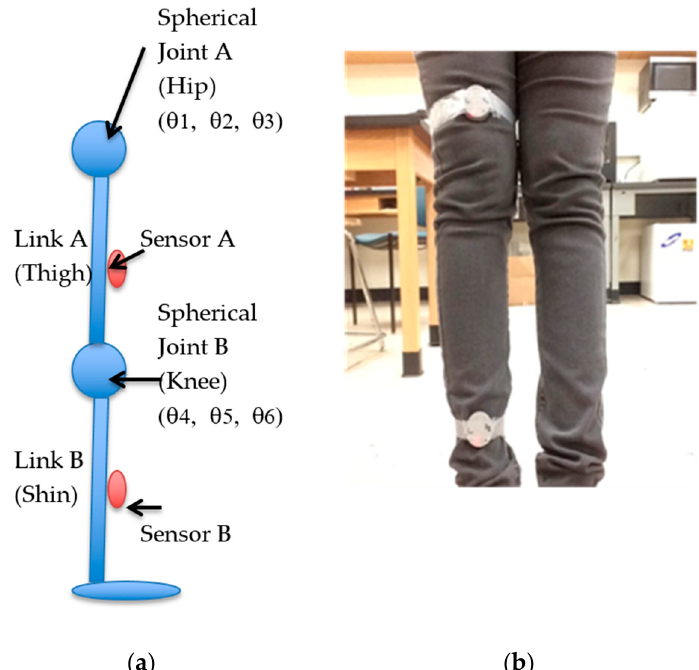
Figure 3. Three-dimensional joint angles: ( a ) description of a human leg model as a kinematic manipulator that consists of two physical links (i.e., thigh and shin) and joints (i.e., hip and knee), each having three rotational joints, the transformation; ( b ) an experimental sensor network setup.